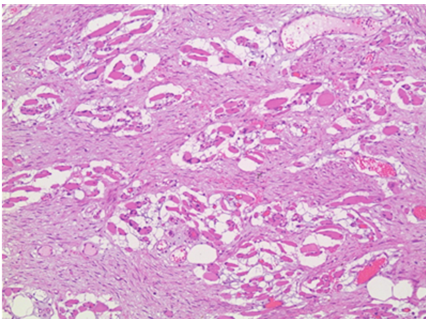
F 1: Desmoid tumor spindle cells surrounding and destroying skeletal muscle cells (hematoxylin-eosin, original magni�cation